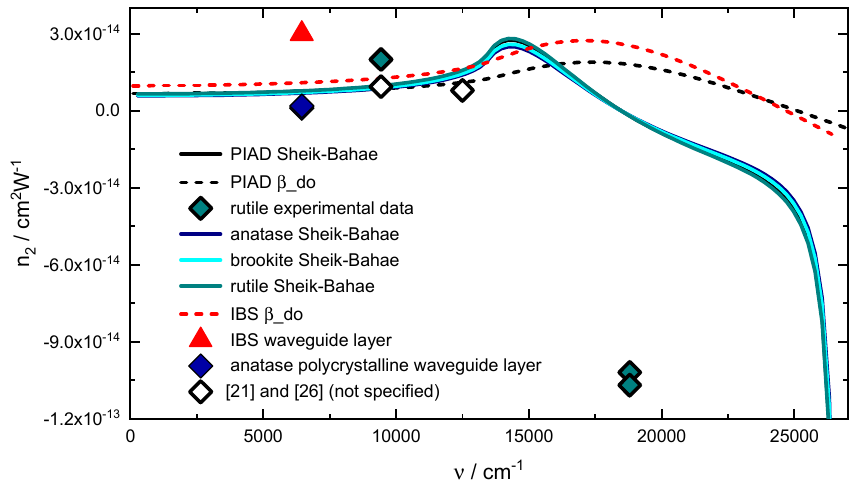
Figure 10. Measured nonlinear refractive indices from different TiO 2 modifications compared to simulations in terms of the Sheik–Bahae approach as well as Equations (3) and (4).